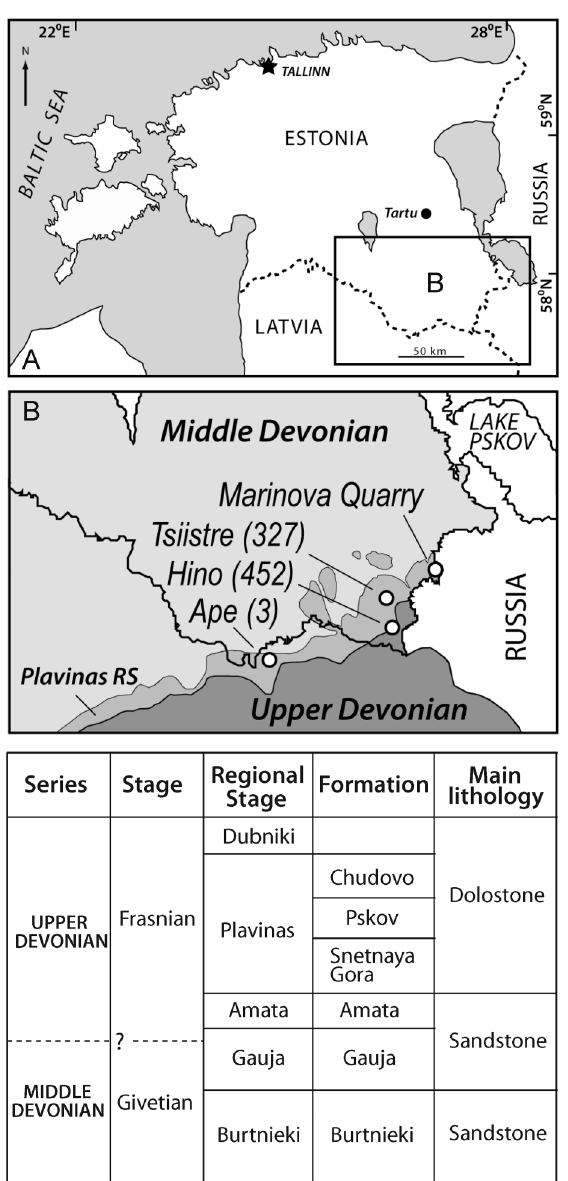
Fig. 1. ( A ) Location of the study area and ( B ) distribution of the rocks of the Plavinas RS with locations of the studied sections. The outcrop area of the Plavinas RS after Sorokin (1978) and Suuroja (1997). The stratigraphical scheme of the Middle(cid:150)Upper Devonian boundary beds of Estonia and Latvia modified after Kleesment et al. (2012) and Mark-Kurik & Pıldvere